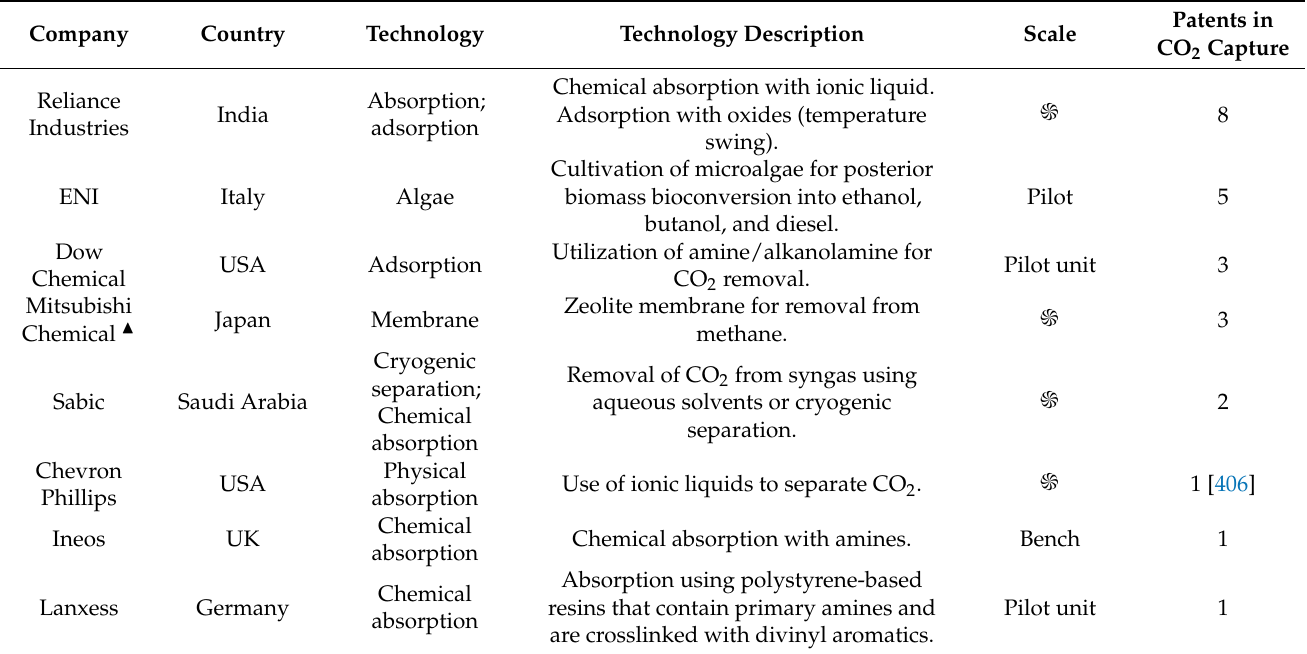
Table 17. Technology description of CO 2 capture solutions developed by chemical and plastic